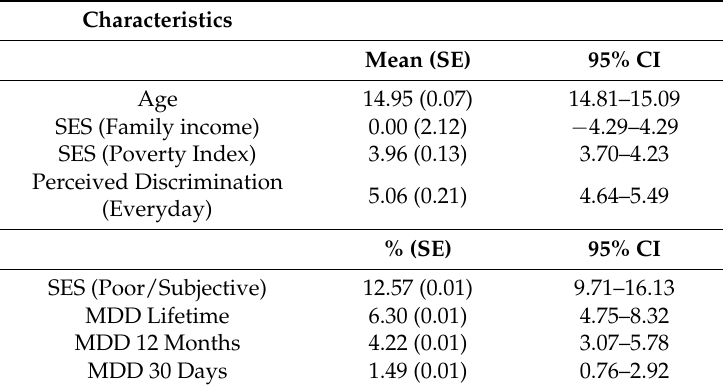
Table 1. Descriptive statistics ( n = 810).